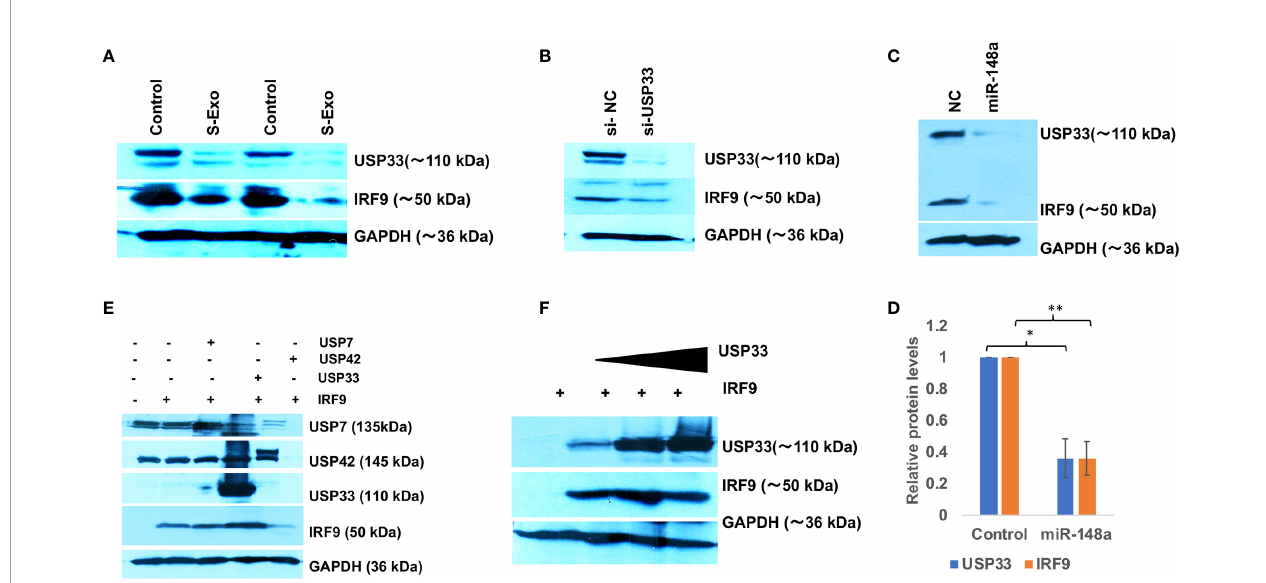
FIGURE 4 | USP33 stabilizes IRF9 levels in human microglia. (A) Western blot analysis of USP33 and IRF9 expression levels in CHME3 cells upon treatment with 2µg of S-exosomes. CHME3 cells were seeded at 1x10 5 density in 6 well plate format, were serum starved for 1 hour before exosomes treatment. Cells were harvested post-48 hours treatment of exosomes, lysed with RIPA buffer and processed for western blot analysis. (B) Immunoblot image showing the impact of depletion of USP33 on cellular levels of IRF9. siRNA against USP33 were transfected in CHME3 cells, at 100 picomoles per well in 6 well plate format with Lipofectamine RNAiMax reagent. After 48 hours cells were harvested, lysed with RIPA buffer and processed for western blotting. (C) Immunoblot image showing reduced levels of USP33 upon miR-148a mimic transfection and its direct in fl uence on IRF9 levels in CHME3 cells. miR-148a mimic were transfected at 100 picomole concentration in CHME3 cells at 1x10 5 cells density in 6 well plate format. (D) Graph bars showing average change in USP33 and IRF9 levels after miR- 148a mimic transfection. Densitometry analysis of western images were performed on Image J software version 1.52q. Data are displayed as mean and mean ± S.E.M. from three independent experiments. Student ’ s t-test have been applied to get the statistical signi fi cance, indicated as ** for p values <0.005. (E) Immunoblot analysis showing the speci fi c deubiquitinase activity of USP33 over IRF9 stabilization. HEK-293T cells have been used for co-transfection experiments in 6 well plate format at 1x10 5 density. 1µg of IRF9 plasmids have been co-transfected with 1µg of USP33, 1µg of USP42 and 1µg of USP7 in various wells. After 24 hours, cells were harvested and lysed in RIPA and followed by western blot analysis. (F) Immunoblot image showing dose dependent impact of USP33 mediated stabilization over IRF9 levels. HEK-293T cells have been co-transfected with 1µg IRF9 plasmids with indicated amount of USP33 plasmids (1µg, 2µg and 3µg). After 24 hours, cells were harvested and proceed for western blotting analysis. All the experiments have been independently repeated at least three times to reach the